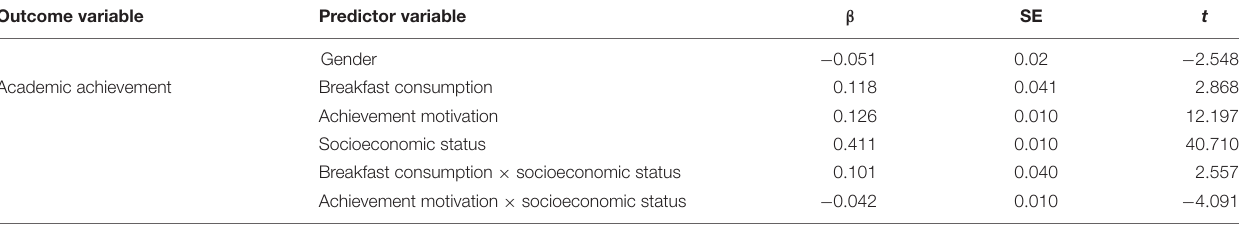
TABLE 4 | Moderated mediation model testing.